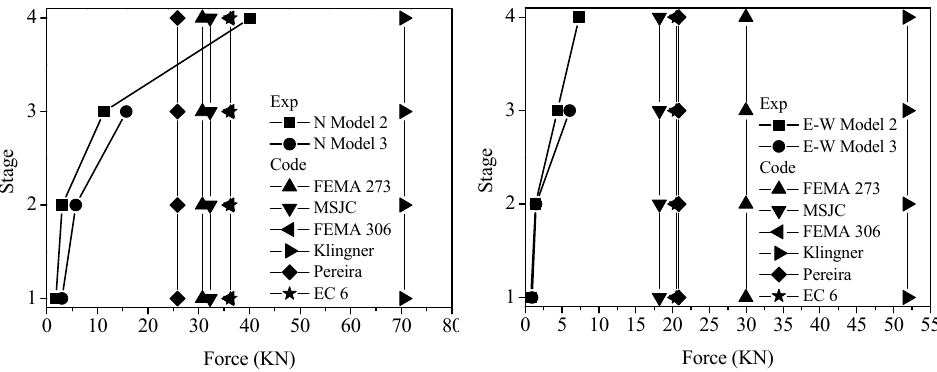
Figure 14. Standard and experimental out-of-plane capacity comparison for models 2 and 3.